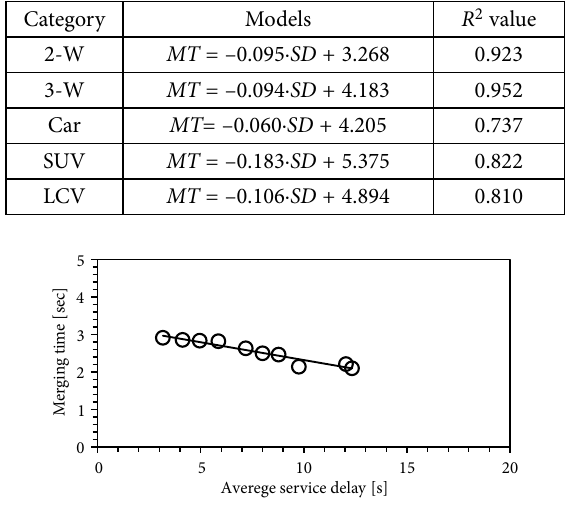
Fig. 12. Effect of SD on MT of